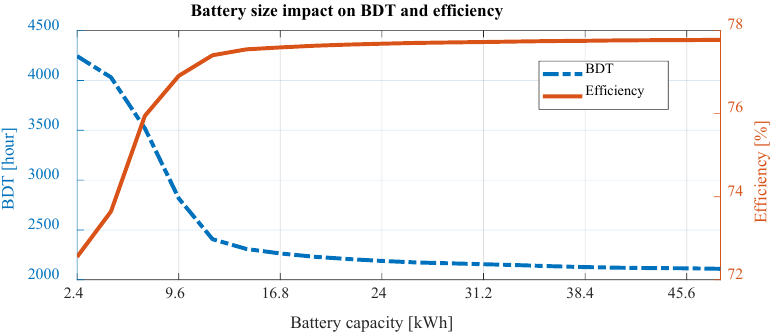
Figure A4. Battery size impact on BDT and efficiency of the DC-RNG by sweeping battery capacity from 2.4 kWh to 48 kWh.